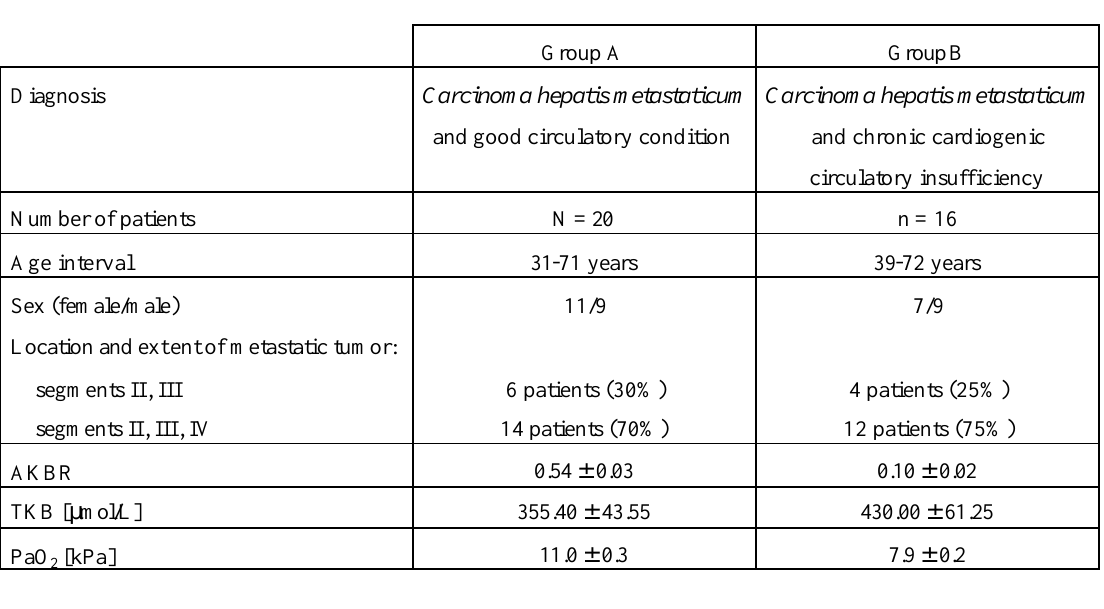
Table 1. Characteristics of the study